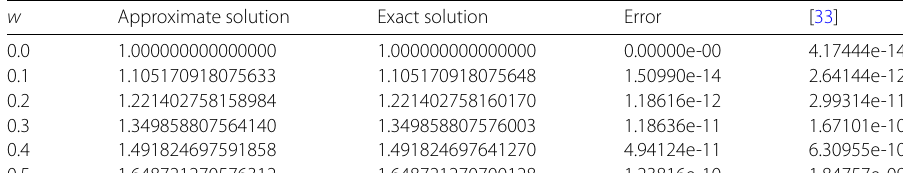
Table 6 Comparison of approximate and exact solution and absolute error of Example 5.6 when J = 4 w Approximate solution Exact solution Error [33] 0.0